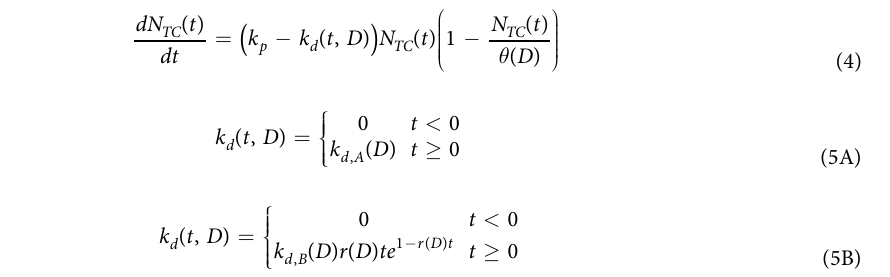
Treatment response model. Doxorubicin canonically induces DNA damage by intercalating DNA bases, stabilizing the topoisomerase II complex, and inducing DNA damage via free radical formation 35 . At high doses (here, dose is defined as a summary statistic of a treatment condition, consolidating drug concentration and drug exposure time, and is denoted D ), extensive DNA damage often results in cell death via apoptosis. Low to mod- erate doses of doxorubicin induce cell senescence, and cell death occurs primarily via mitotic catastrophe 38, 39 . Whereas apoptosis is immediate (on the order of hours to days), mitotic catastrophe is a relatively protracted process (on the order of several days). This is likely due to the fact that cells must progress through the cell cycle to reach mitosis for this mode of death to occur, and doxorubicin is known to cause cell cycle arrest. These pro- cesses were modeled by a logistic growth model, Eq. (4), modified by either one of two time-dependent response functions, Eq. (5A) and (B), reflecting the distinct forms of cell death, as follows: